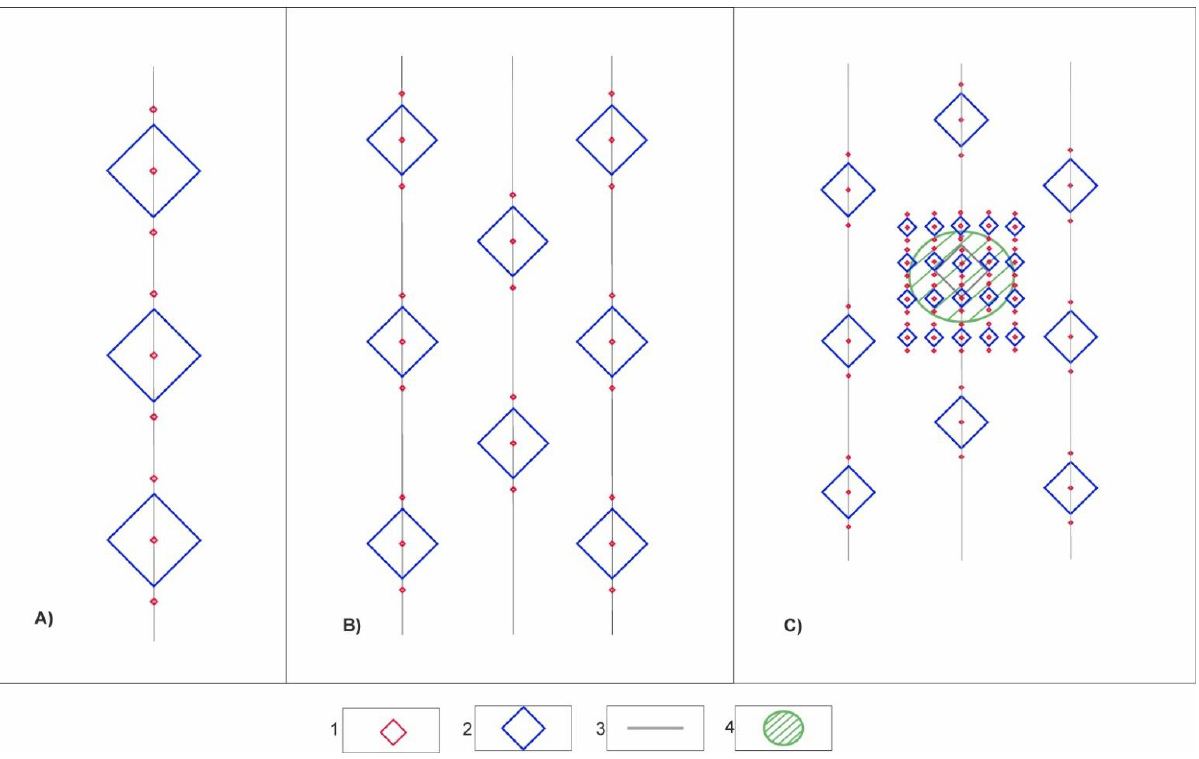
Figure 3. sTEM survey designs. ( A ): Profile survey; ( B ): 3D survey; ( C ): Higher-density measurements of a prospect. 1 = receiver; 2 = transmitter; 3 = profile; 4 = local target.